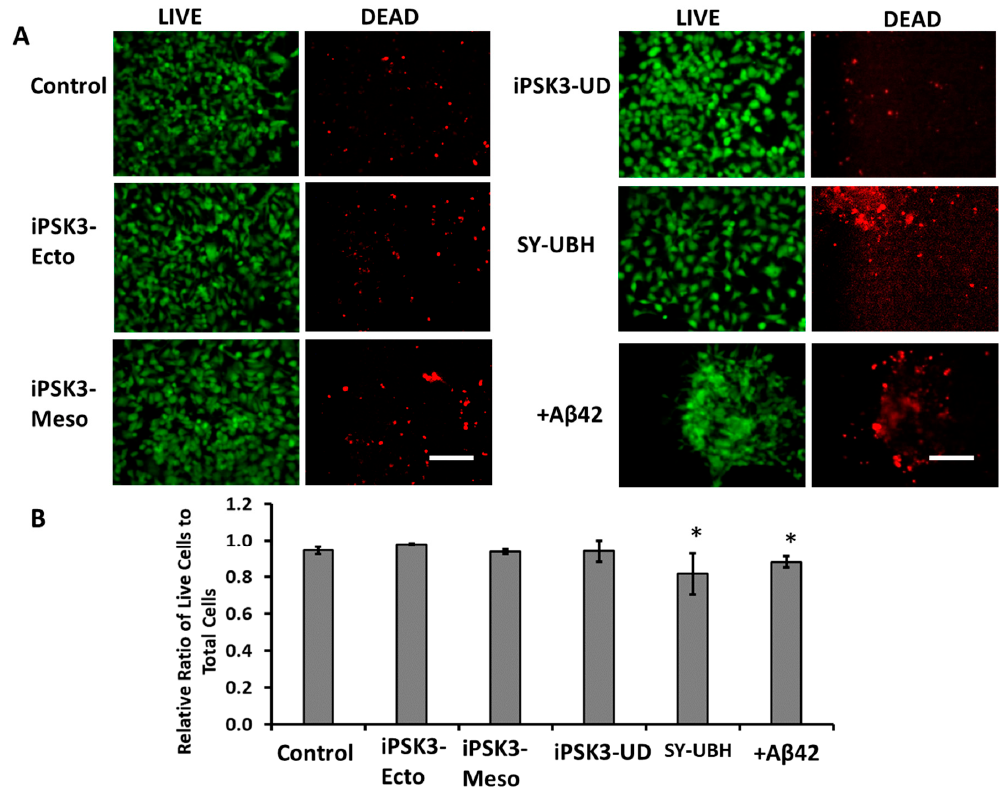
Figure 6. Effects of hiPSC-derived EVs on viability of A β 42-treated iNPC spheroid outgrowth. Cell viability was examined by LIVE/DEAD assay that utilizes Calcein AM (green) (for live cells) and ethidium homodimer-1 (red) (for dead cells). Day 30 cortical spheroid outgrowth was treated with A β 42 oligomers and different groups of hiPSC-EVs for three days before the analysis. ( A ) Fluorescent images of LIVE and DEAD cells; Blue: Hoechst. ( B ) Quantification of cell viability ( n = 3). Scale bar: 100 µm. * indicates p < 0.05 compared to the control condition.